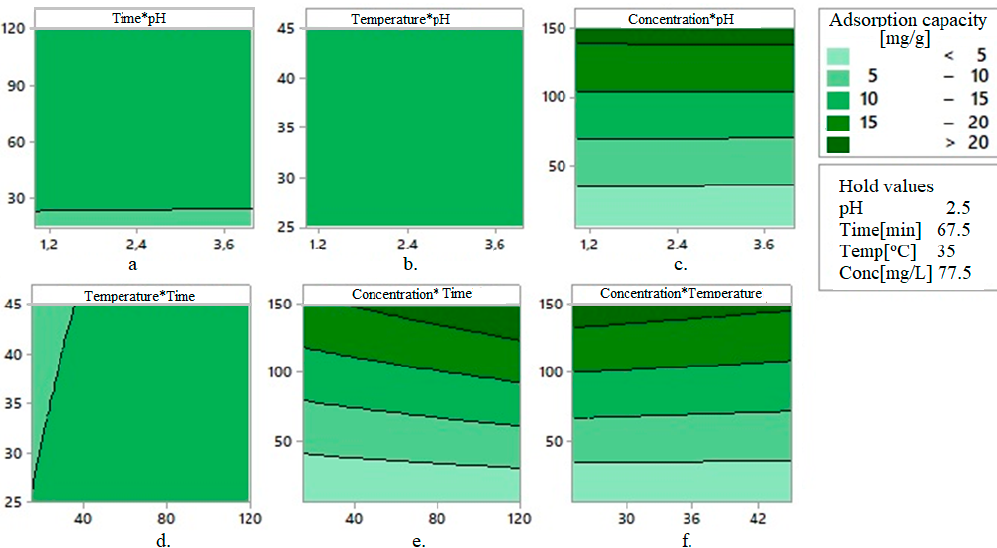
Figure 7. Interactions between the control factors and the response of the adsorption process (ad- sorption capacity).